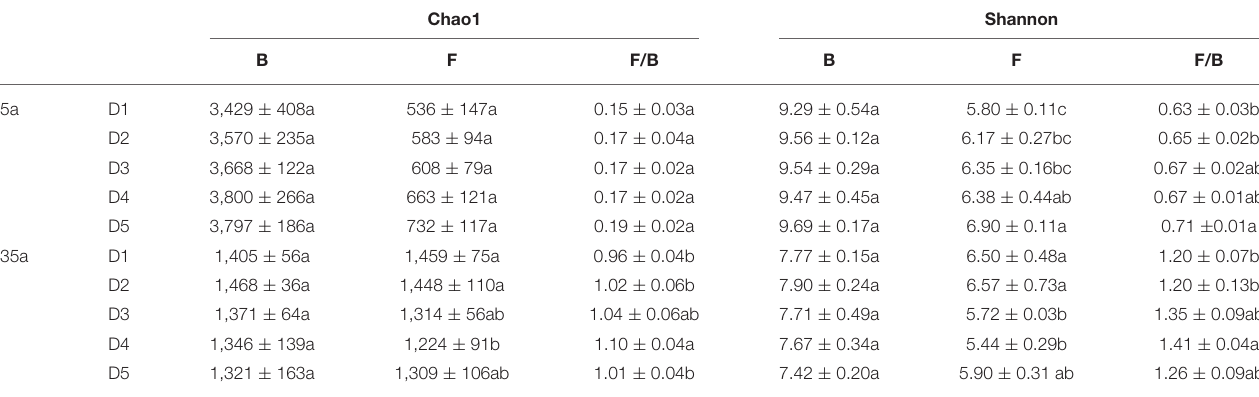
TABLE 2 | Richness and diversity indices of bacterial (B) and fungal communities (F) in 5-year-old (5a) and 35-year-old (35a) Chinese fir plantations of different stand densities. Chao1 Shannon